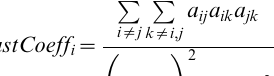
(TIF) Figure S2 The average overlap of covariance matrix for different intervals (8 ns to 300 ns) with the final covariance matrix calculated over the 600 ns trajectory. (TIFF) Figure S3 Flexibility of gp120 during the MD simulations of YU2 strain. (A) The protein is colored by the RMSF per residue. Blue represents residues that are rigid during the simulation while red represents residues that are flexible during the simulation. (B) Comparison of the RMSF per residue during three different MD simulations and one FIRST simulation. (TIF) Figure S4 RMSD of the conformations along the 600 ns trajectory in the YU2 simulation. (A) The plot is colored by the RMSD between any two frames during the simulation. Blue represents conformations with low RMSD (high structural similarity) and red represents conformations with high RMSD (low structural similarity). (B) The RMSD of each subdomain of the protein (as compared to the initial conformation) during the simulation is plotted as a function of time. (TIF) Figure S5 The RMSF per residue during the (A) HXB2 and (B) CAP210 during the 600 ns simulation. (TIF) Figure S6 The protein colored by the community each residue belongs to. The backbone of the protein is shown in tube. Again, it would be good to label some of the structures. (TIF) Figure S7 The average number of hotspot residues in 10 blocks of binding sites is plotted. To reduce the noise, the binding sites were arranged by decreasing binding leverage and were divided into 10 blocks. Block 1 contains the sites with the highest binding leverage (10%) while block 10 contains 10% of the sites with the lowest binding leverage. Higher numbers of hotspot residues occur in the sites with highest binding leverage in Hxb2 and YU2 simulations while a higher number of hotspots occur in sites with moderate binding leverage in the CAP210 simulation. In all three simulations, the sites with the lowest binding leverage tend to have a smaller number of hotspot residues. (TIF) Table S1 The overlap of the covariance matrix between different simulations. The values of overlap are between 0.5 and 1.0, indicating that the major coupled motion in the protein is similar for the three different gp120